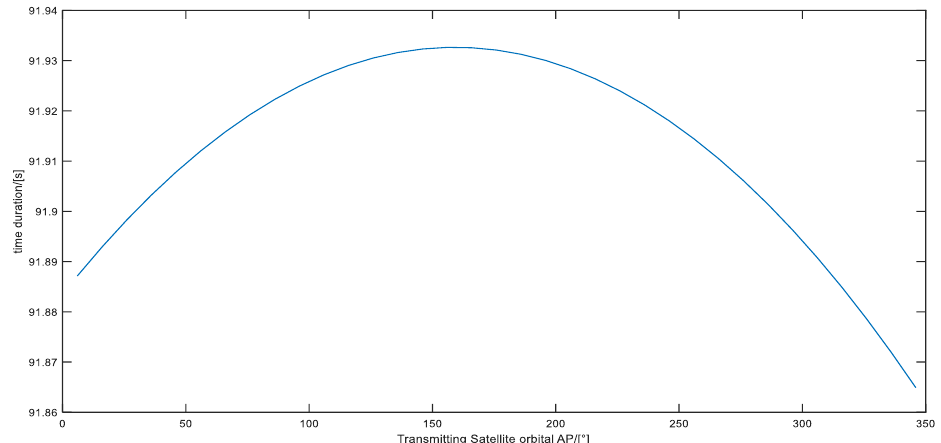
Figure 3. Variation in occultation duration with satellite inclination.